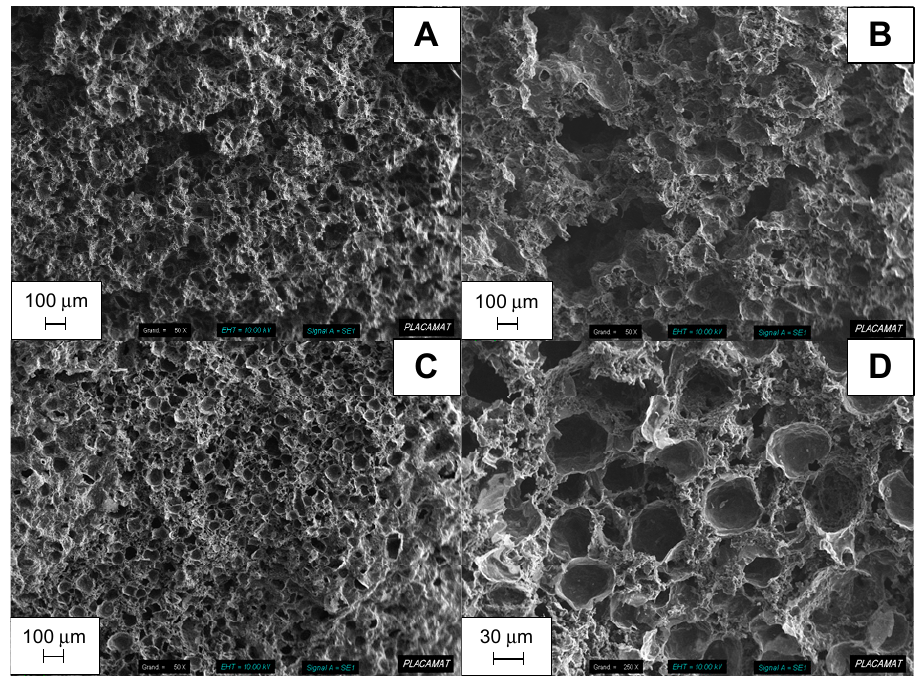
Figure 4. Scanning Electron Microscopy images of the samples: ( A ) SucNaCl0.80; ( B ) SucNaCl1.00; ( C , D ) SucNaCl1.25.